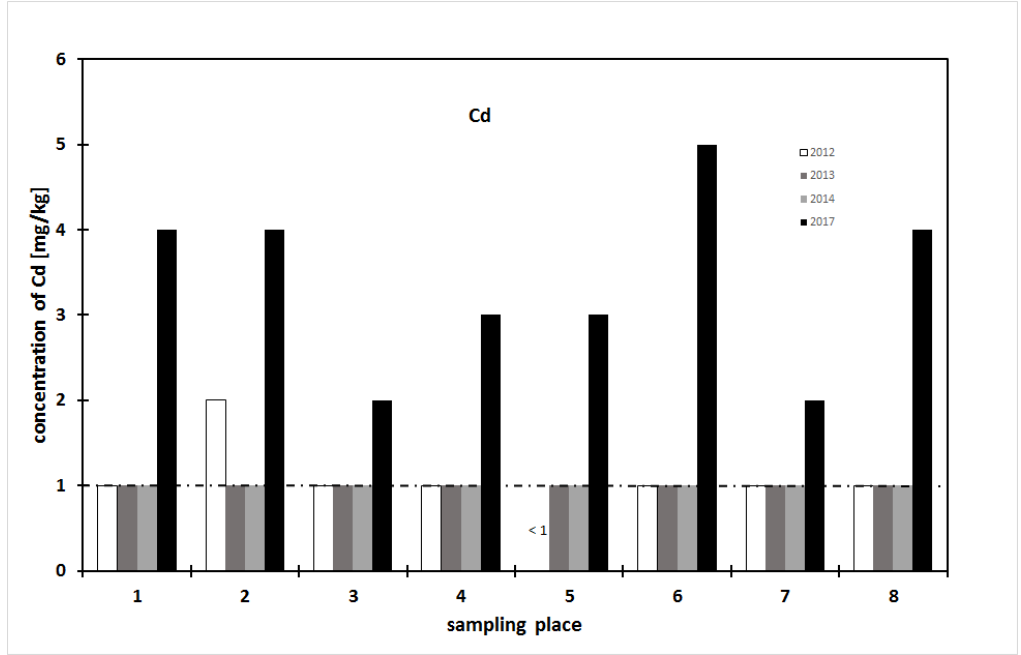
Figure 2. Content of Cd in sediments at individual sampling sites in 2012, 2013, 2014, and 2017. The dashed line represents the limits for risk elements according to Annex No. 1 of the Czech Decree 257/2009 Coll. [30]. Limit of quantification <1 mg/kg. Water 2019 , 11 , x FOR PEER REVIEW